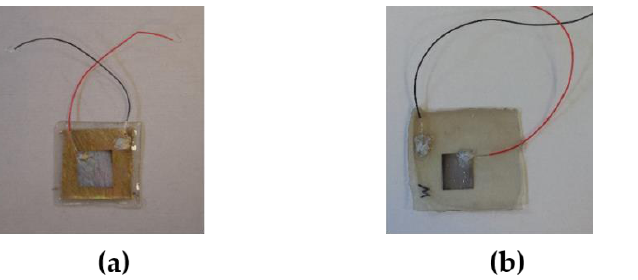
Figure 4. Photograph of PENGs devices made from ZnO NWs deposited on ( a ) Au/ZnO and ( b ) ITO/ZnO seed layer structures.